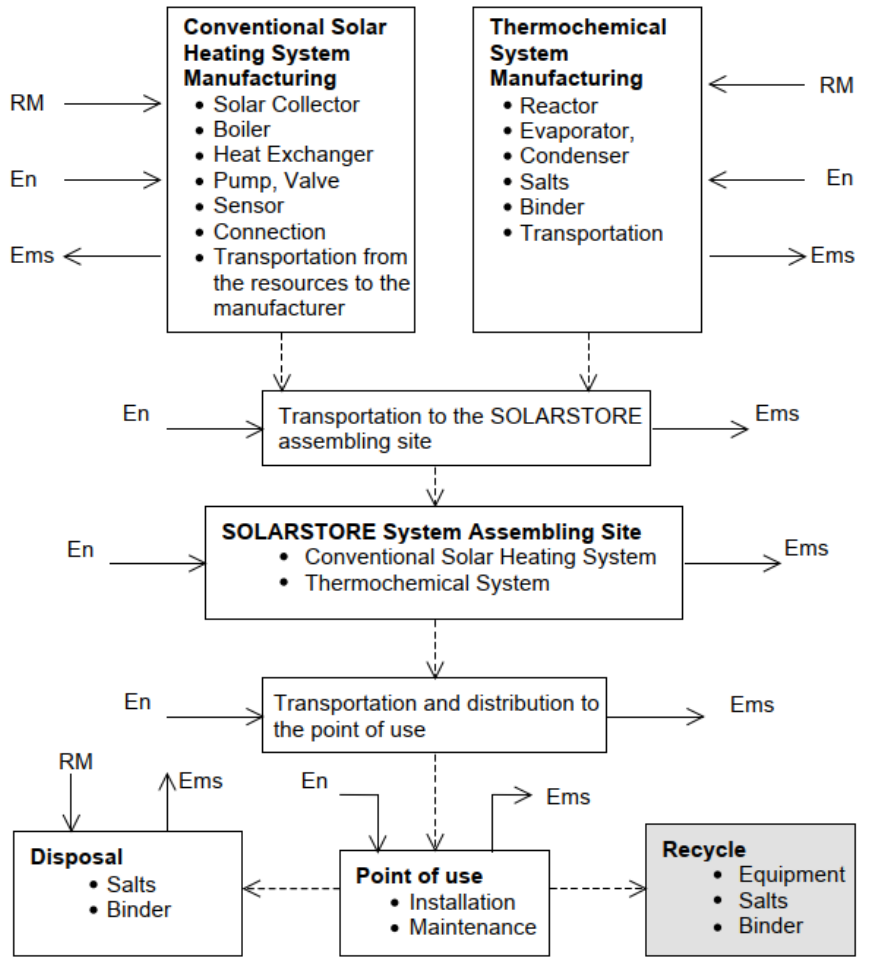
Figure 5. LCA boundary of conventional solar heating and a thermochemical heating system (reprinted from [49], with permission from Elsevier).